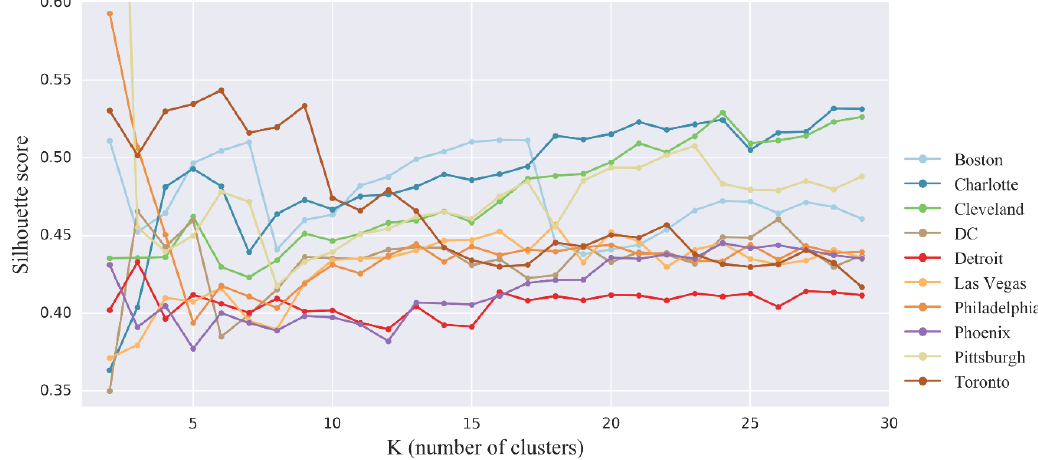
Figure 5. Silhouette scores for different Ks for different cities (large-grained spatial bins).